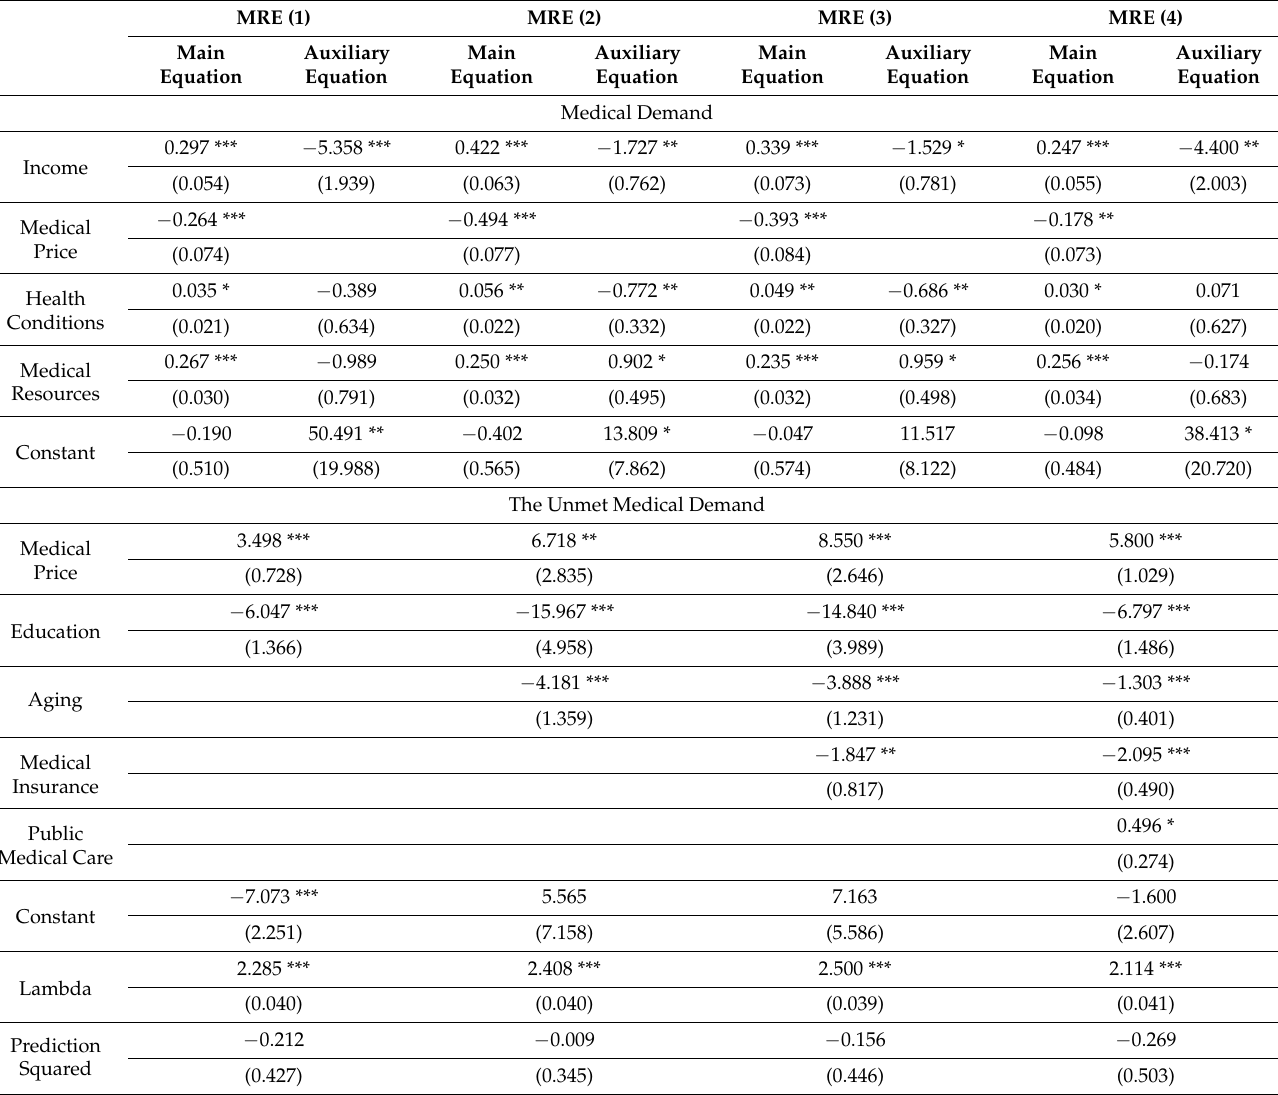
Table 4. Estimations for medical